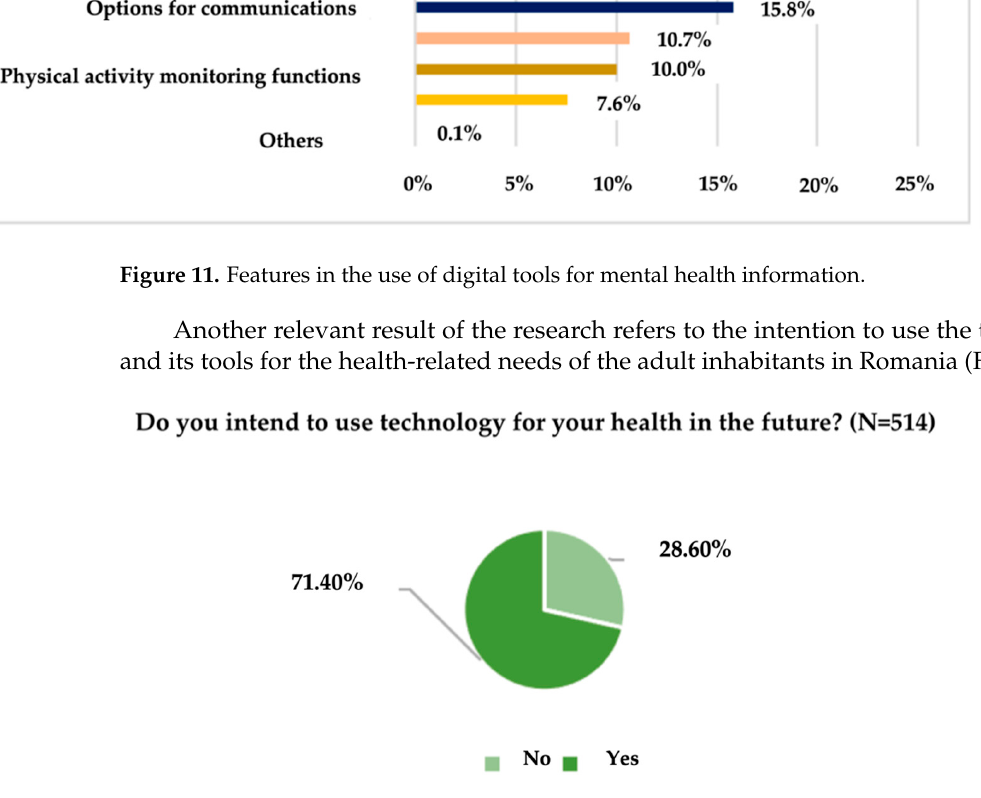
Figure 12. The intentions to use health technology.